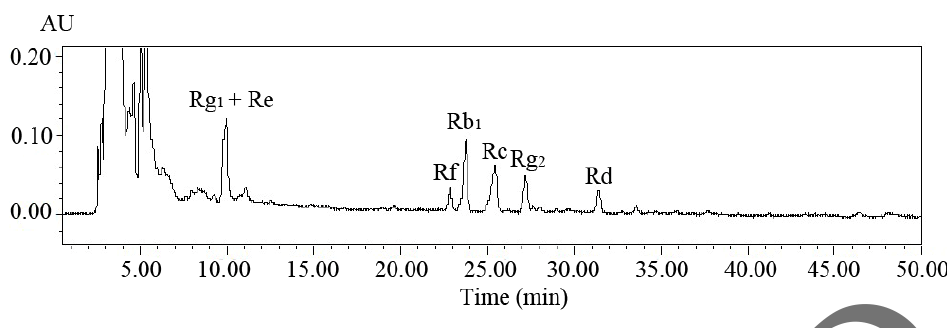
Figure 1. A chromatogram of the ginseng extracts. AU refers to absorbance unit.